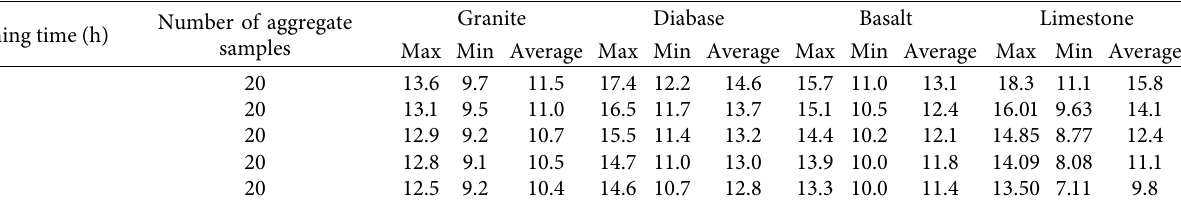
Table 9: The variation of the JRC 3D values of aggregates with different lithologies with the polishing time. Polishing time (h)